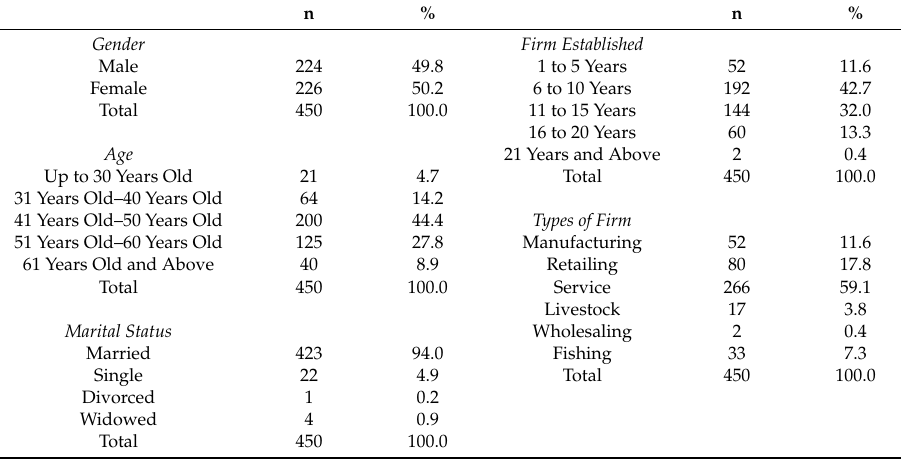
Table 1. The profile of the respondents.